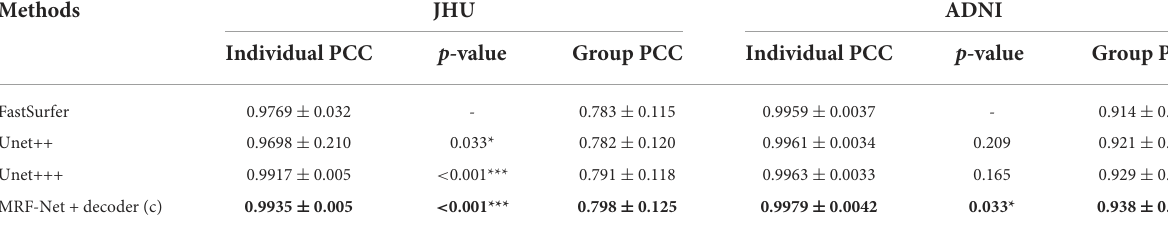
TABLE 7 Estimations of volume on Pearson correlation coefficient (PCC) in terms of individual-level and group-level. Methods